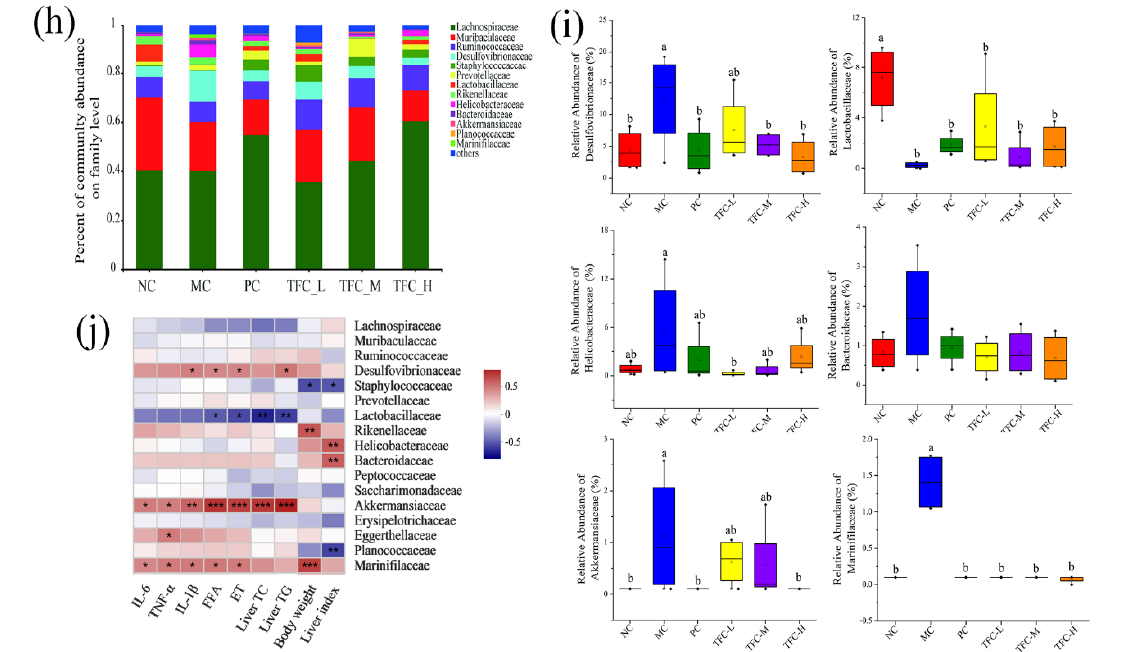
Figure 9. Effects of TFC on intestinal microbial composition and diversity. ( a ) Shannon index, ( b ) Chao1 index, ( c ) PCoA, ( d ) Venn diagram, ( e ) the number of OTU, ( f ) phylum-level abundance, ( g ) relative abundances of the gut microbiota at the phylum levels, ( h ) family-level abundance, and ( i ) relative abundances of the gut microbiota at the family levels. ( j ) Heat map of Spearman’s rank correlation between related indexes of NAFLD and changes of gut microbiota distribution at the family level. Red color indicates positive correlation, and blue color indicates negative correlation; * p < 0.05, ** p < 0.01, and *** p < 0.001. Different letters indicate significant differences; abc p <